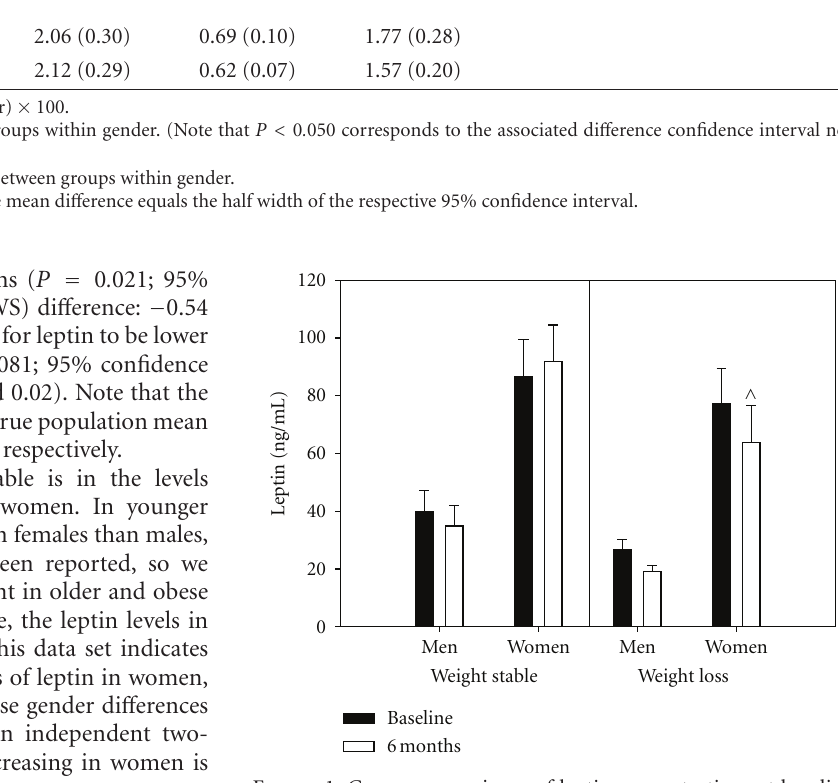
Figure 1: Group comparisons of leptin concentrations at baseline and 6 months for women and men. ∧ Represents significant di ff er- ences between WS and WL for women at the 6 months at P < 0 . 100. Bars present sample means augmented with their standard errors. All versus women mean di ff erences are statistically significant with group and sample time